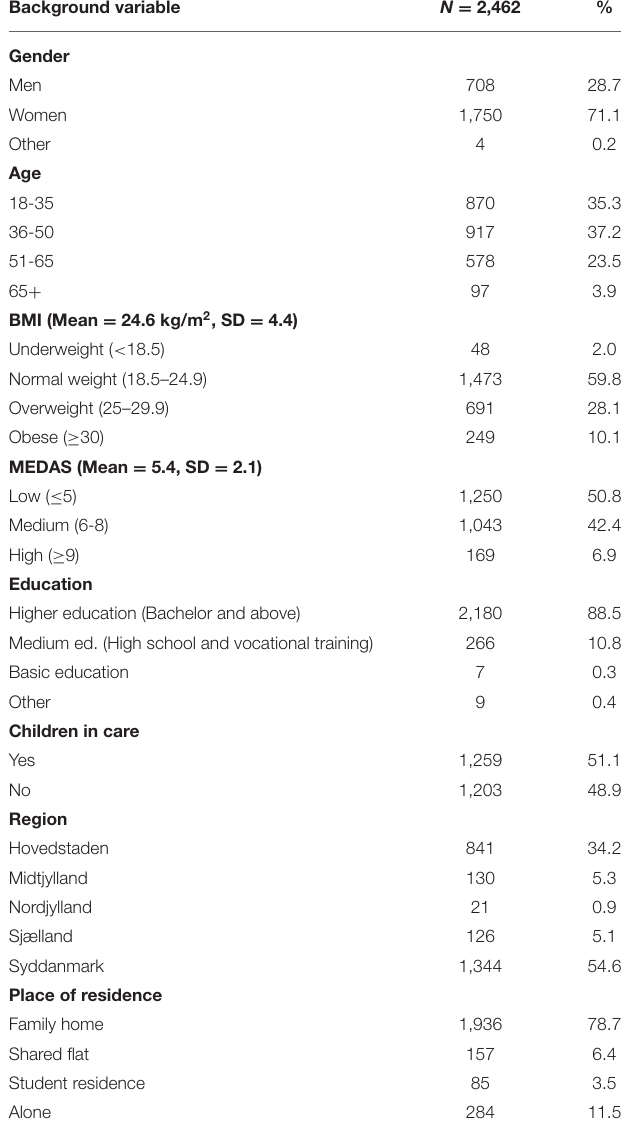
TABLE 1 | Socio-demographic and anthropometric characteristics of the sample population ( N = 2,462). Background